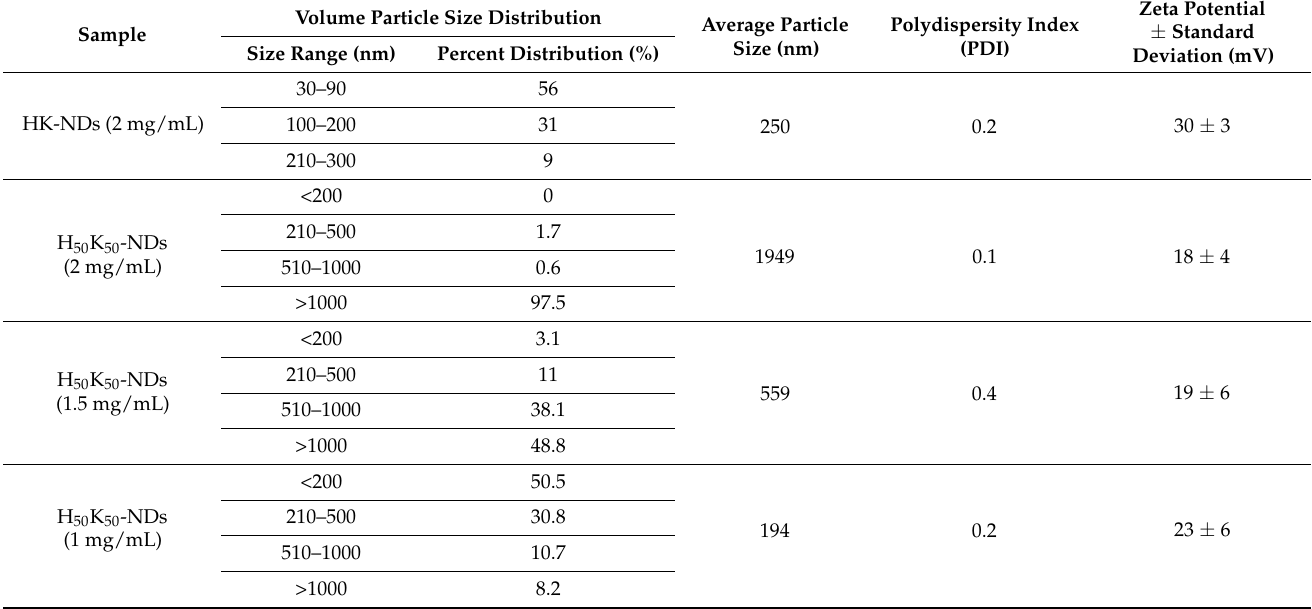
Table 1. Particle size distribution and zeta potential of HK-NDs and H 50 K 50